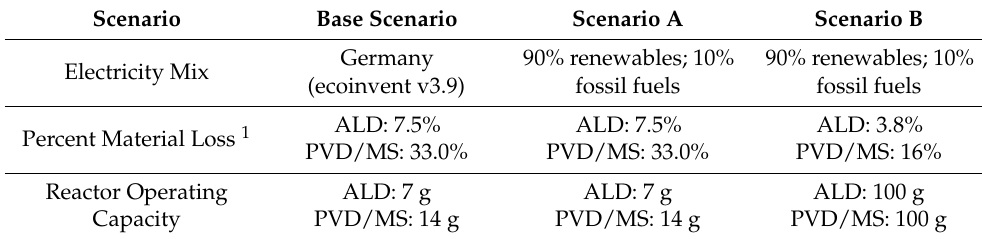
Table 5. Description of Scenarios for Environmental Assessment.